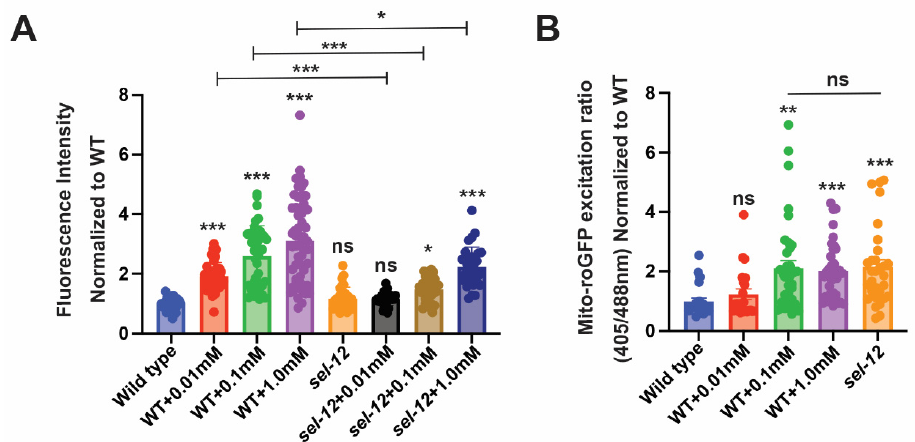
Figure 4. sel-12 mutants have decreased SKN-1 activity in response to oxidative stress. ( A ) Quantification of gst-4p ::GFP expression in animals treated with paraquat. (n ≥ 28). ( B ) Ratio of oxidized to non-oxidized roGFP1 in the mitochondria of ALM neurons of animals treated with paraquat. (n ≥ 22). Ns p > 0.05, * p < 0.05, ** p < 0.01, *** p < 0.001 using one-way ANOVA with Kruskal-Wallis test. Comparisons are made to wild type unless otherwise indicated. Error bars indicate mean +/ − SEM.